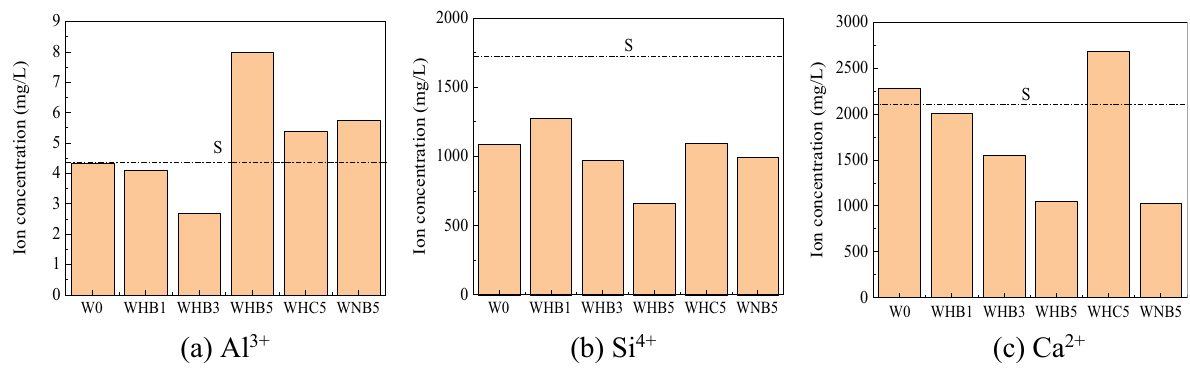
Fig. 10 Ion release concentration of iron tailings in cement solution